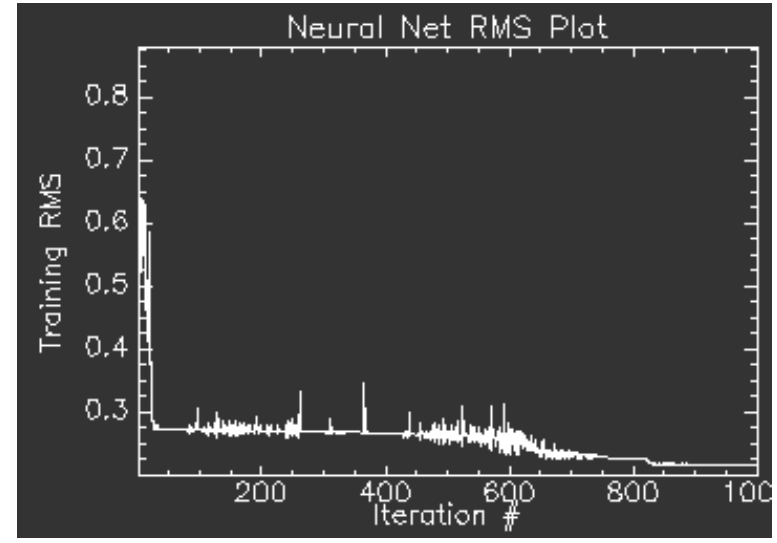
Figure 7. The RMSE vs. iterations for NN classification of the corrected image for a sample of Nicolet vegetation species training sets.